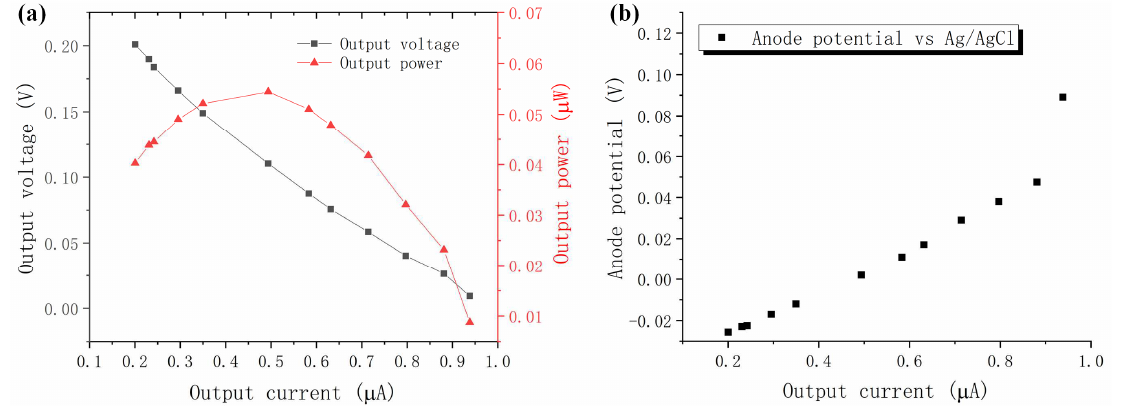
Figure 3. ( a ): Polarization curves of the microscale MFC biosensor, including the output voltage versus output current and output power versus output current curves; ( b ): Anode potential versus output current for the microscale MFC biosensor during polarization characterization.